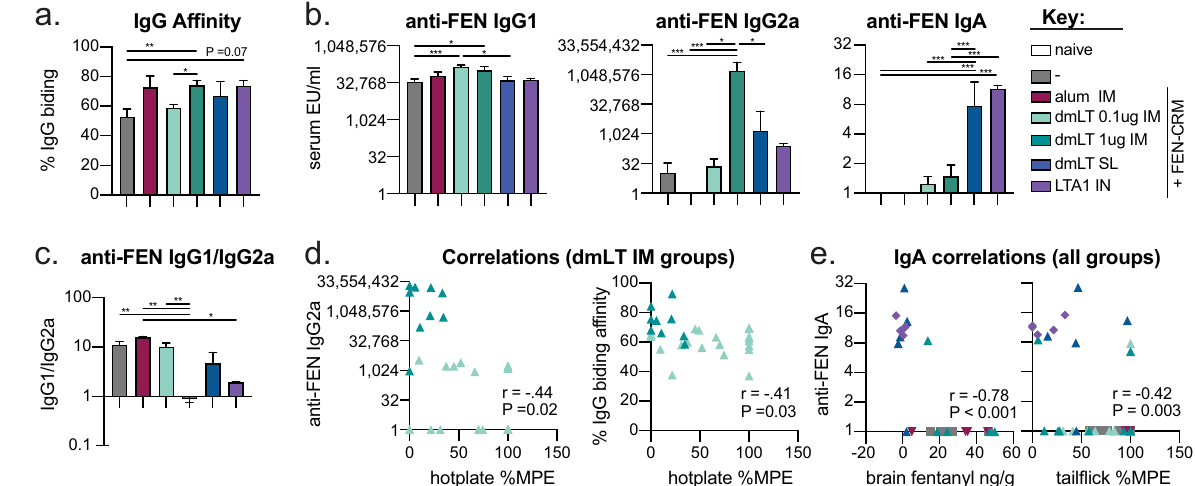
Fig. 7 Anti-FEN antibody af fi nity, IgG2a, and IgA isotypes contributed to protection from fentanyl challenge in dmLT and LTA1 immunized animals. Serum samples from fentanyl challenge experiments were further characterized for anti-FEN immunity. a IgG antibody binding af fi nity calculated as % IgG binding to FEN-TT in the presence of a chaotropic agent (week 6). b Compiled serum anti-FEN (FEN-TT) serum IgG1 (week 8), IgG2a (week 8), IgA (week 10) ELISA from tailbleeds. c Ratio of serum anti-FEN (FEN-TT) IgG1/IgG2a. (Zero values for IgG2a were replaced with a 1.) d Correlation between hotplate antinociception vs IgG2a or IgG binding af fi nity for 0.1 and 1 μ g dmLT IM immunization groups only. e Correlation between brain fentanyl levels or tail fl ick antinociception %MPE vs anti-FEN serum IgA (week 10) for immunized groups. Bars at mean + s.e.m. with signi fi cance determined by ANOVA paired with Bonferroni post-hoc test as shown (* P < 0.05, ** P < 0.01, *** P < 0.001). Spearman correlations P values and correlation coef fi cient ( r ) indicated on relevant